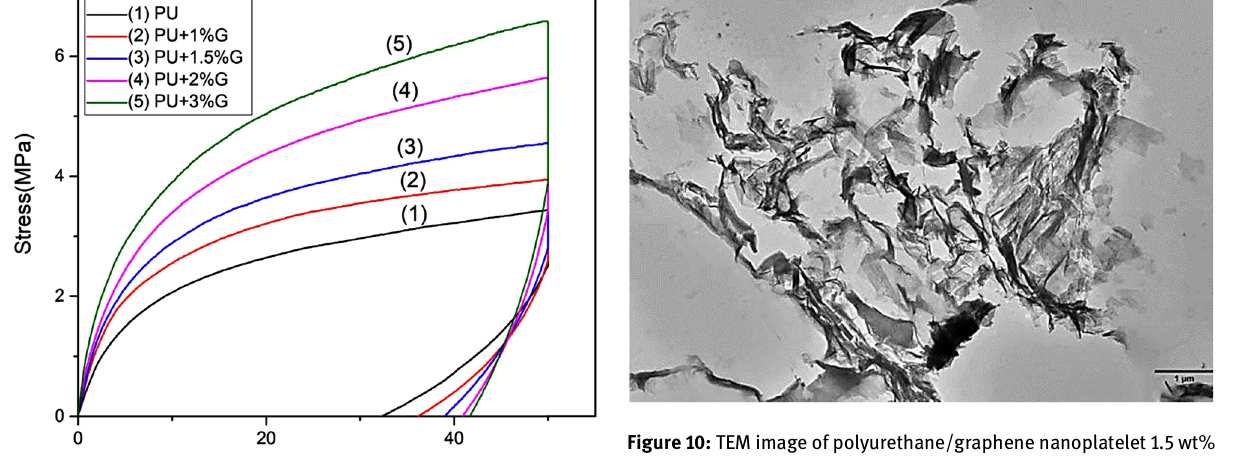
Figure 10: TEM image of polyurethane/graphene nanoplatelet 1.5wt% nanocomposite ( 106 ) . Reproduced with permission